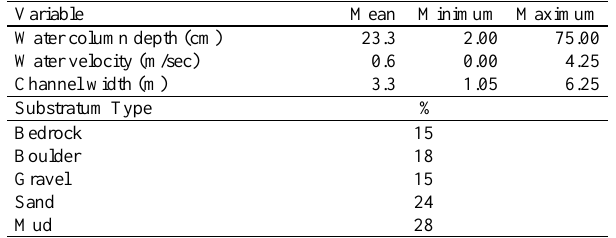
Table 2. Environmental characterization of the study site at Roncador stream, including maximum, minimum and mean of depth; water velocity and stream width; and percentage values of substratum type: bedrock, boulder (diameter between 5.0 and 30.0 cm), gravel (diameter between 2.5 and 5.0 cm), sand, and